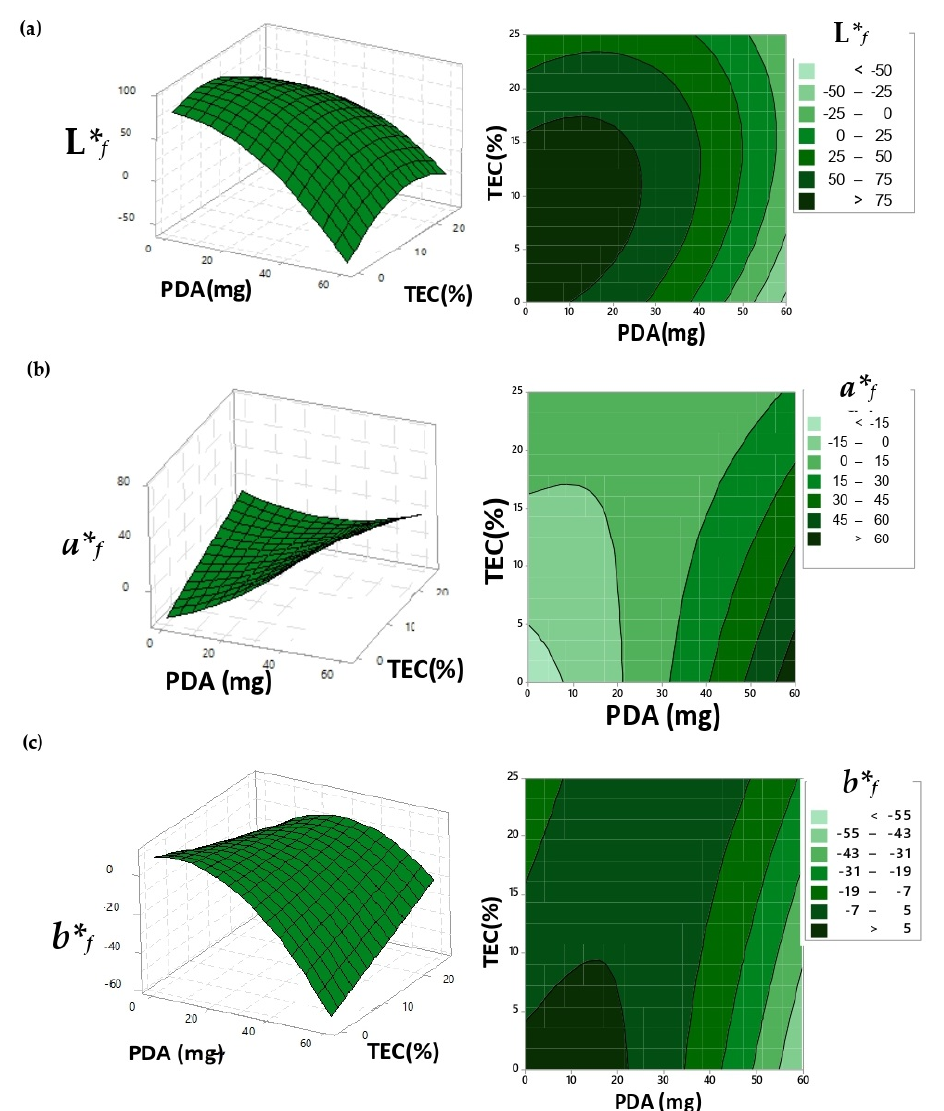
Figure 2. Response surface and contour graphic to the adjusted surface of the coordinates: ( a ) L * f ; ( b ) a* f and ( c ) b* f for the films after the exposure of UV light and different values of pH and temperature.